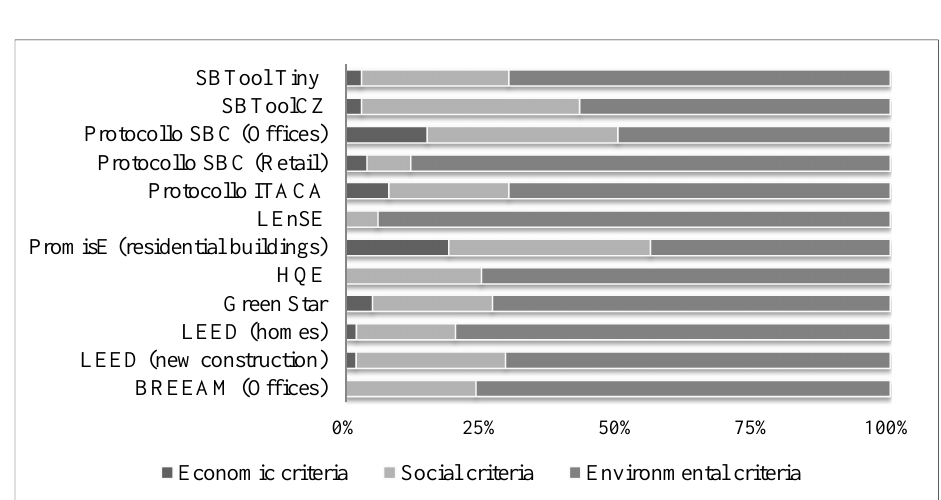
Figure 1 – Distribution of weights among groups of criteria in selected assessment